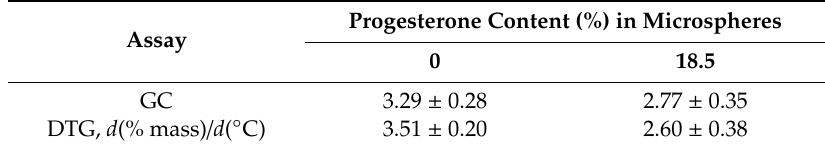
Figure 8. (Red) DTG curves of blank PLGA microspheres and those with 18.5% of progesterone. Methylene chloride (MC) was used for microencapsulation. (Blue) DTG curves of PLGA microspheres containing 0 or 20.7% of progesterone. Microspheres were prepared using ethyl formate (EF) as a dispersed solvent. Table 4. Comparison of the contents (%) of residual methylene chloride in PLGA microspheres determined by DTG and GC.